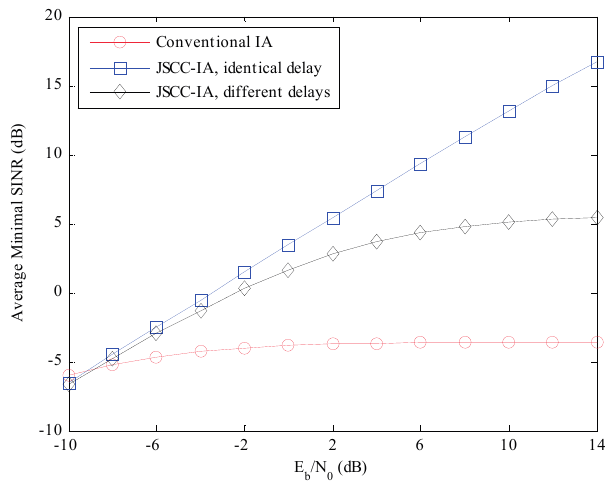
Figure 7. The average minimal received SINR of the conventional IA scheme and the JSCC-IA schemes with identical/different propagation delays in the (4 × 4, 1) 20 symmetric networks.